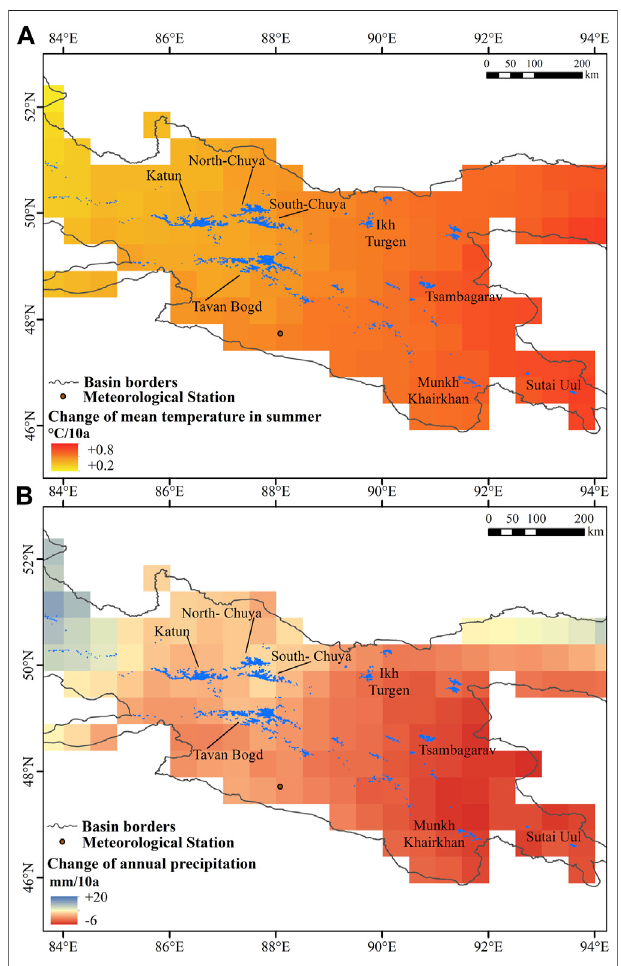
FIGURE 11 | (A) Change of mean temperature in summer, and (B) change of annual precipitation.